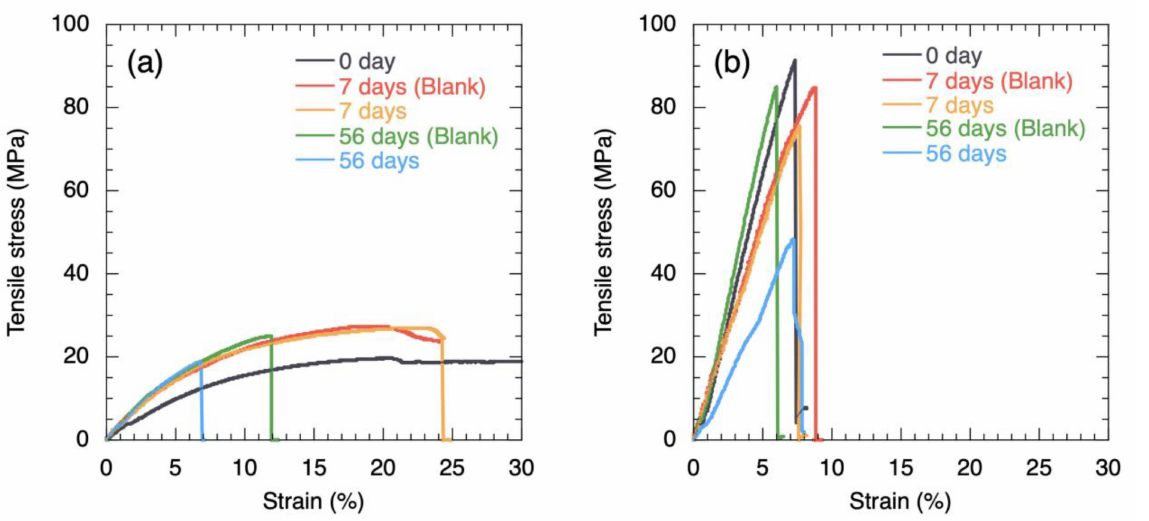
Figure 3. Stress–strain curves for ( a ) PBS and ( b ) PBS–BF composite specimens 7 and 56 days after the start of the decomposition test. Blank refers to specimens immersed in the ISP1 without addition of bacteria.